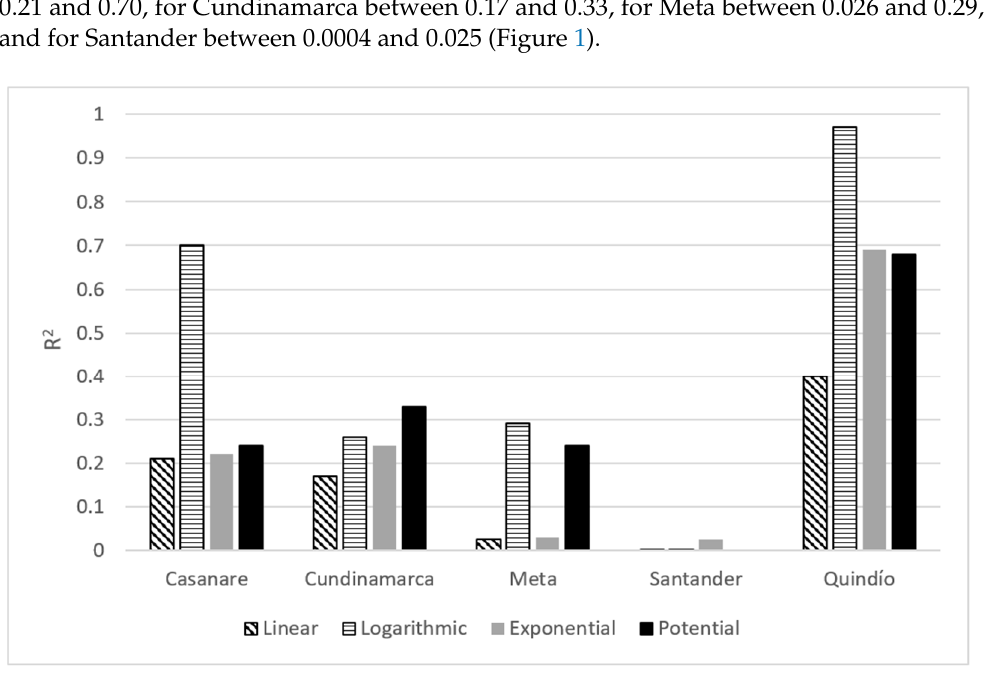
Figure 1. R 2 of regressions between MRW and average travel time between various municipalities and the capital city of their department.